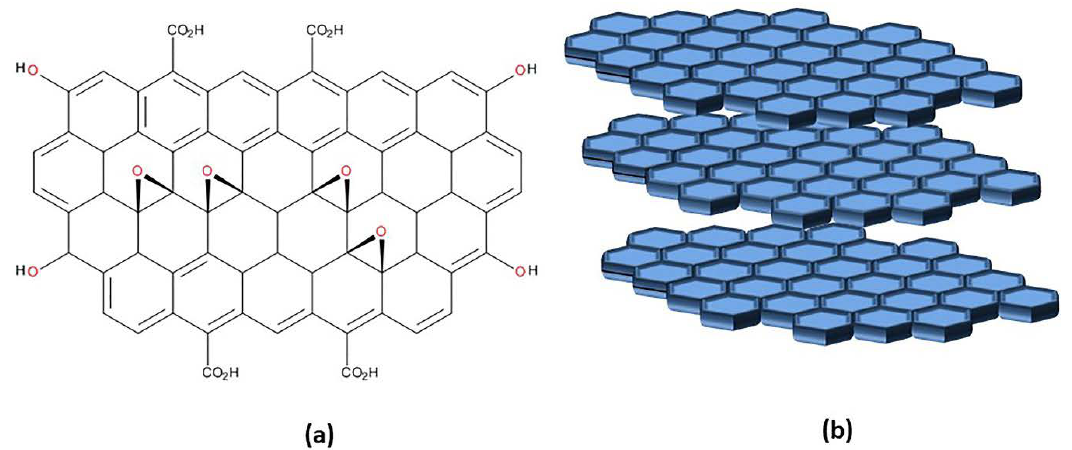
Figure 6. Chemical structure of graphene oxide (GO) ( a ) and multilayered planar structural arrangement of GO ( b ).